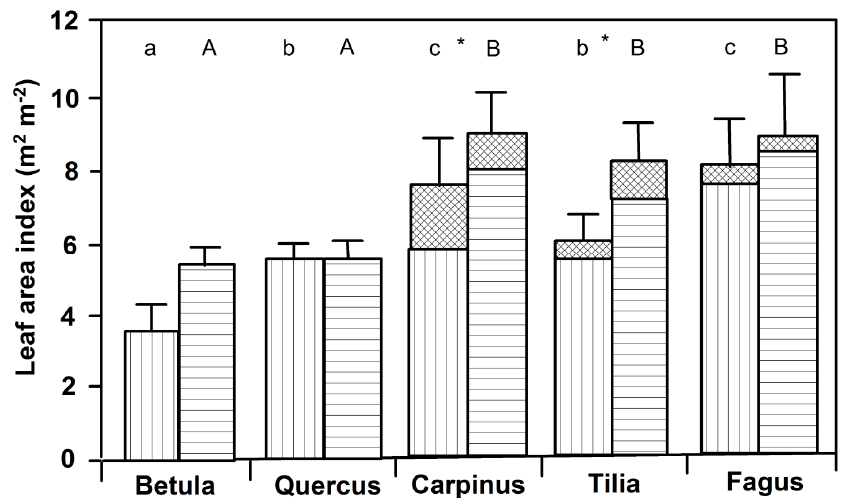
Figure 7. Leaf area indices of the five tree species in two years (1998 and 1999) according to litter bucket measurements in two sites per species (each 10 litter buckets per site). Given are means and SD. Only the Betula and Quercus stands were monospecific; a small proportion of other tree species were admixed in the Carpinus , Tilia , and Fagus stands. The leaf area of these admixed species is indicated by cross-hatching on top of the bars. Significant species differences in 1998 are indicated by different small letters, and in 1999, by different capitals (Scheffé test, p < 0.05). Significant differences between years are indicated by *